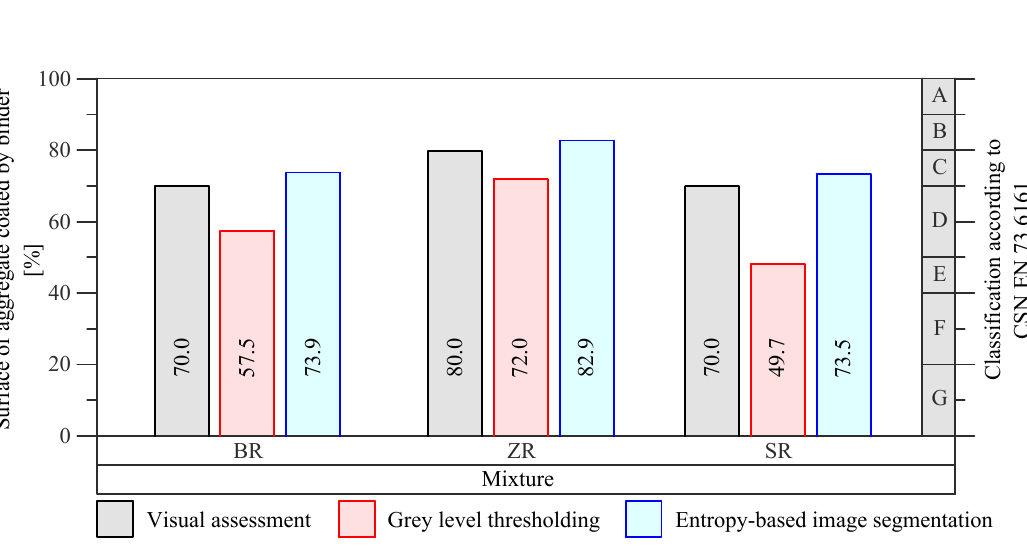
Table 2. Asphalt mixtures summarization.